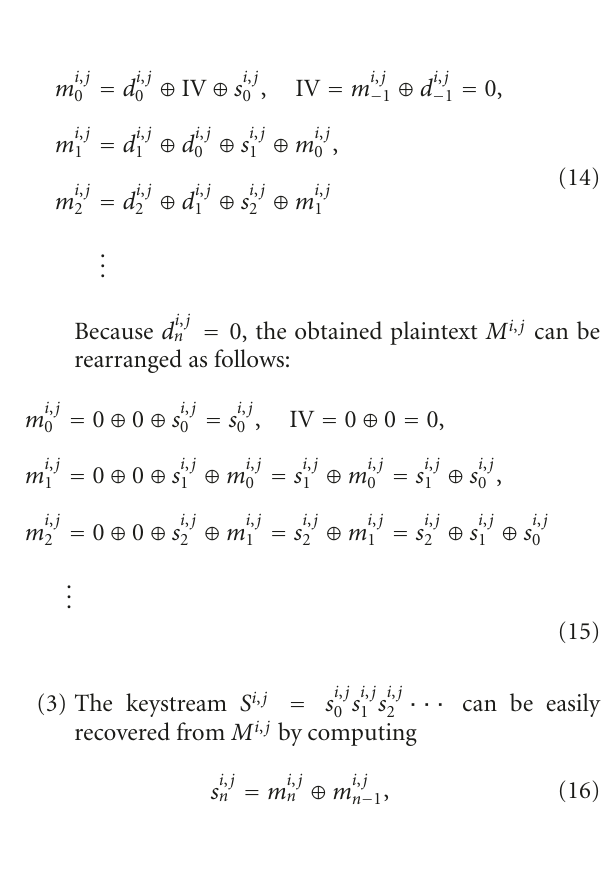
Figure 3: Simulations results of chosen-plaintext attack (CPA): (a) plaintext image P ; (b) encrypted image C ; (c) chosen plaintext image M and (d) encrypted image D of M and (e) recovered image P from C by the